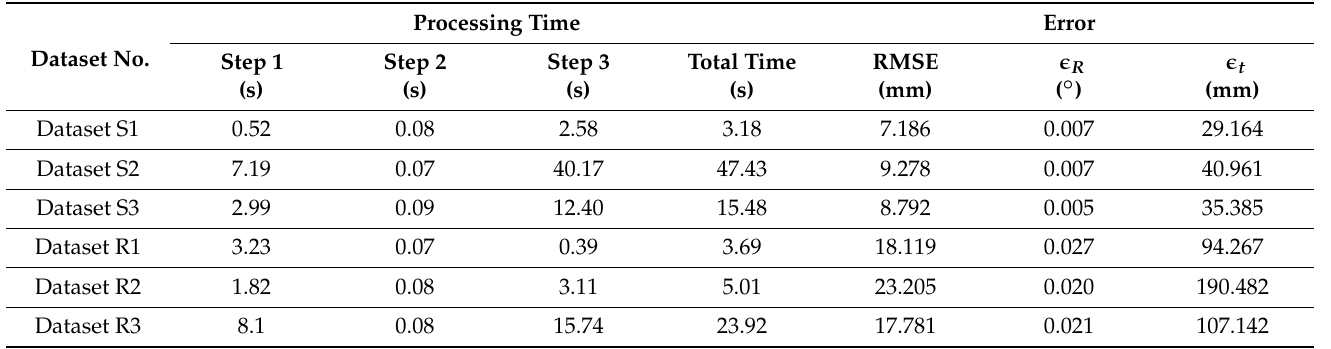
Table 3. Details concerning the processing time and accuracy error according to each